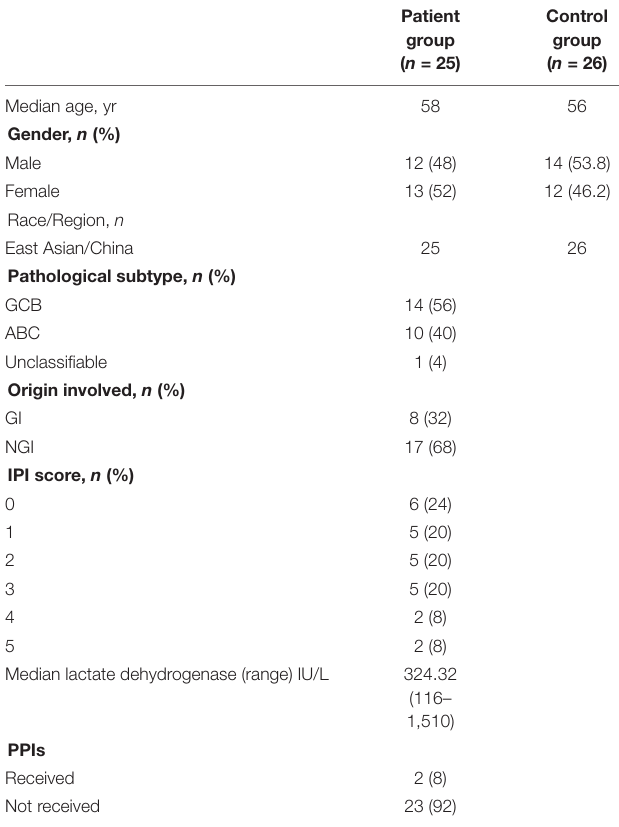
TABLE 1 | Baseline characteristics of patients and